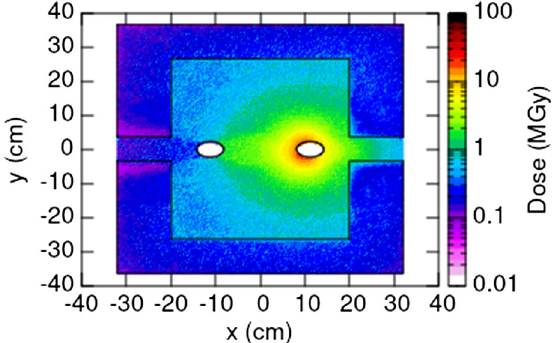
FIG. 7. Dose distribution on the MBW.B6L7 non-IP face for a cumulative loss of 10 16 top energy protons per beam on the collimation system. Values are averaged longitudinally over 7 cm.